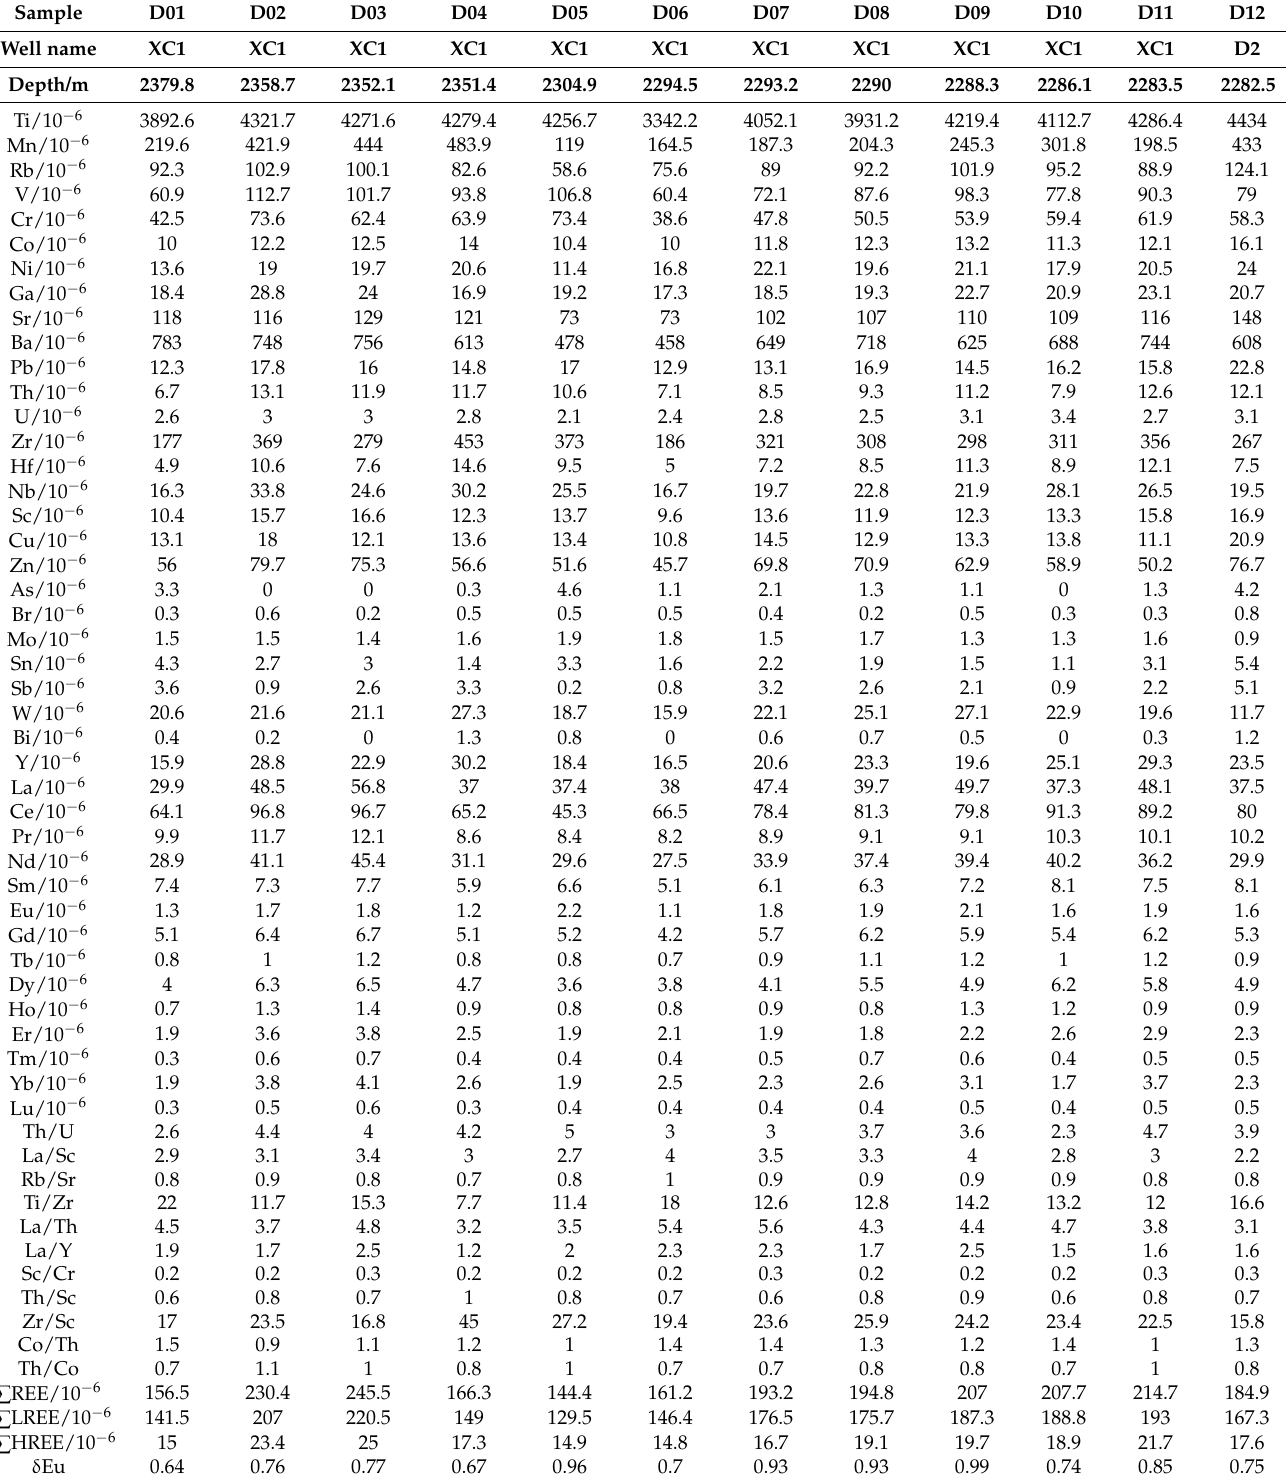
Table 2. Characteristics of trace elements of samples from the J 2 z 1 Formation of Wudun